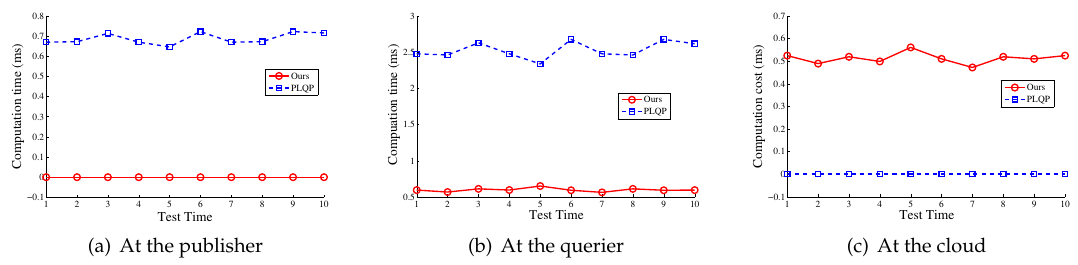
Figure 8. The time comparison of performing location distance compute between our scheme and PLQP.